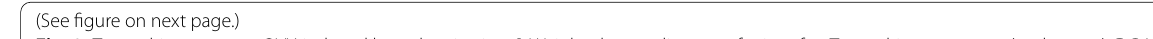
5). B RANKL/ = SEM. * P < 0.05, ** P < 0.01, ±